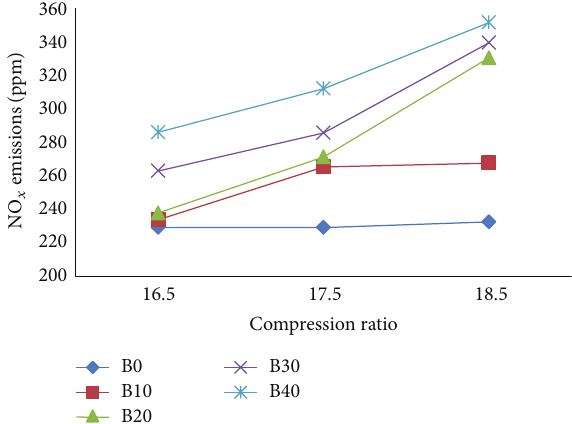
Figure 10: Variation of NO 𝑥 emission with compression ratio for diesel and all ester blends at 75% of rated load conditions.